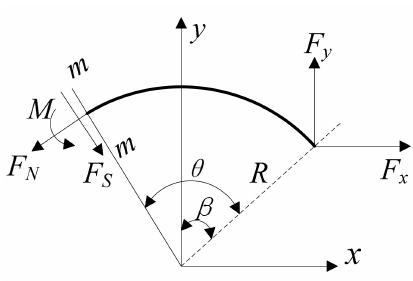
Figure 4. Stresses on curved bar of the hook using section